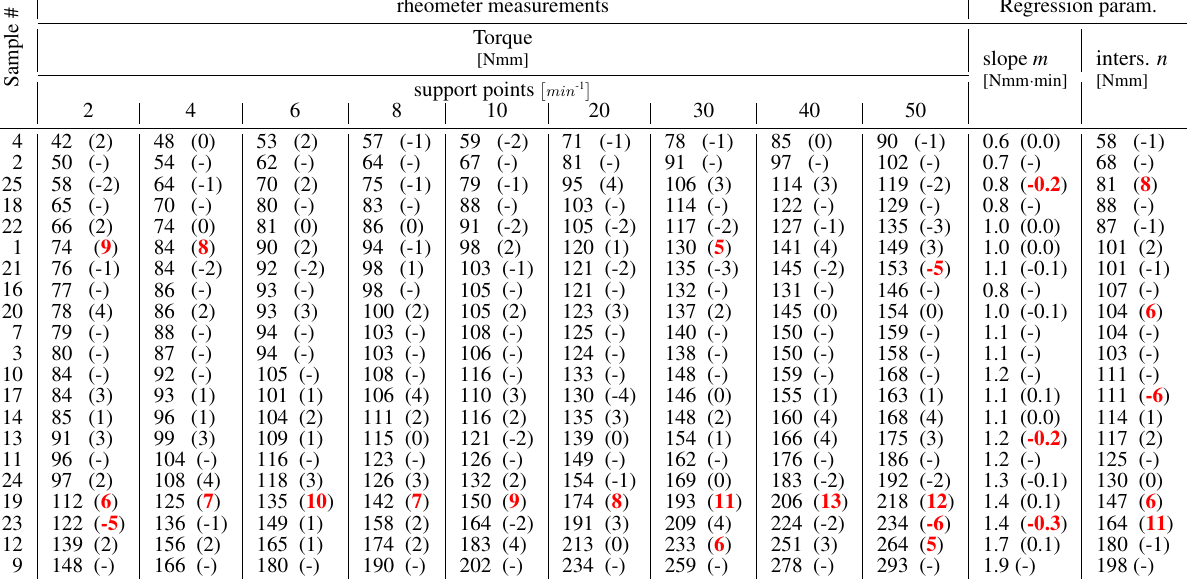
Table 1. Reference values determined with the rheometer. In addition, the parameters are given, which result from a regression between the support points 20 min -1 and 50 min -1 . In case two measurements were available per sample, the mean value is given. In addition, the difference between these measurements is shown in brackets (large differences are indicated in red). The sample number in the first column is only used to refer to individual samples.